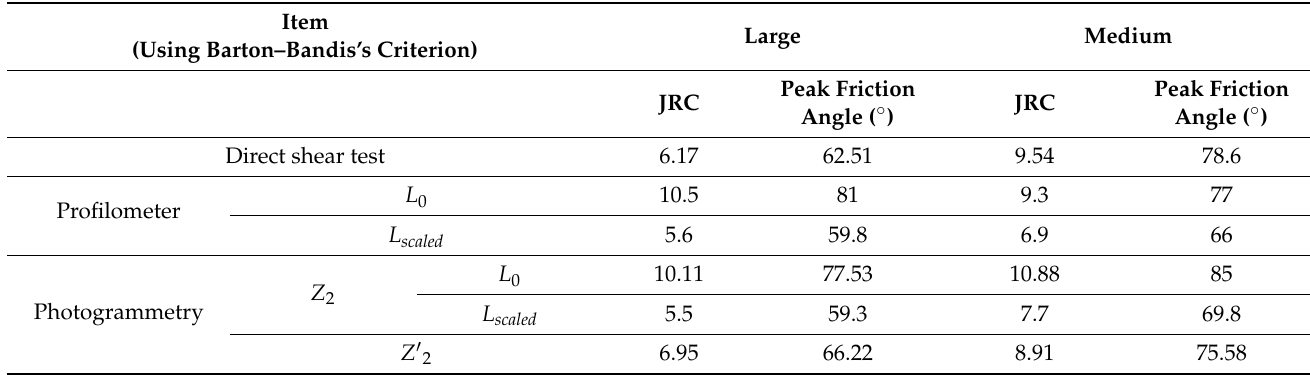
Table 5. Comparison of the peak friction angle